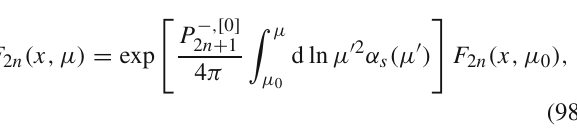
Figure 3 shows the effect of evolving the MMHT2014lo68cl PDF set to μ = 10 GeV for differ- ent values of ξ , including the DGLAP limit ξ → 0, using the numerical solution of Eq. (28) as implemented in APFEL++ . Evolution is probed for x ranging between 10 − 3 and 1, rel- evant for the fixed target (Jefferson Lab, COMPASS) and collider (EIC, EIcC) experiments, while the evolution range spans two orders of magnitude in the hard scale μ 2 , from 1 to 100 GeV 2 . The top-left plot displays the up-quark